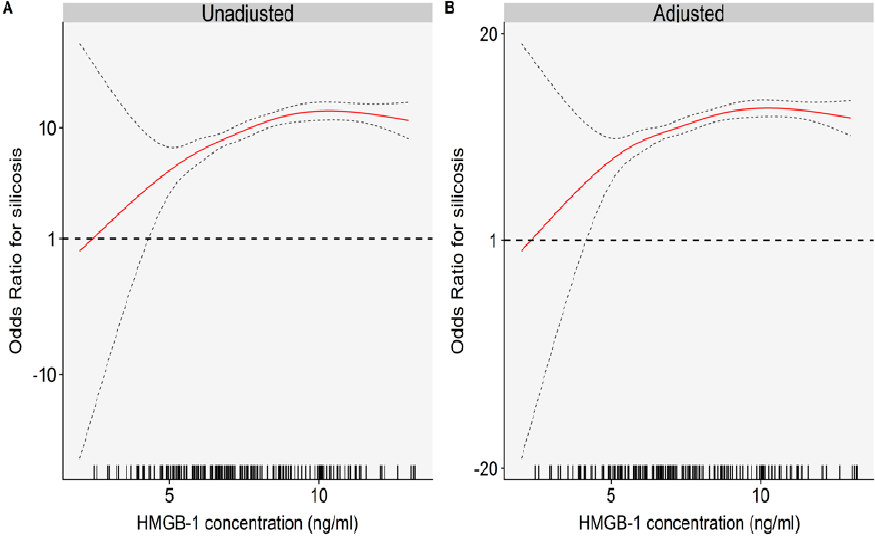
Figure 2. Nonlinear associations between HMGB-1concentrations and silicosis: ( A ) single factor logistic regression; and ( B ) model was adjusted for age (continuous), BMI (continuous), smoking status (no, yes), drinking status (no, yes), and passive smoker (no, yes).